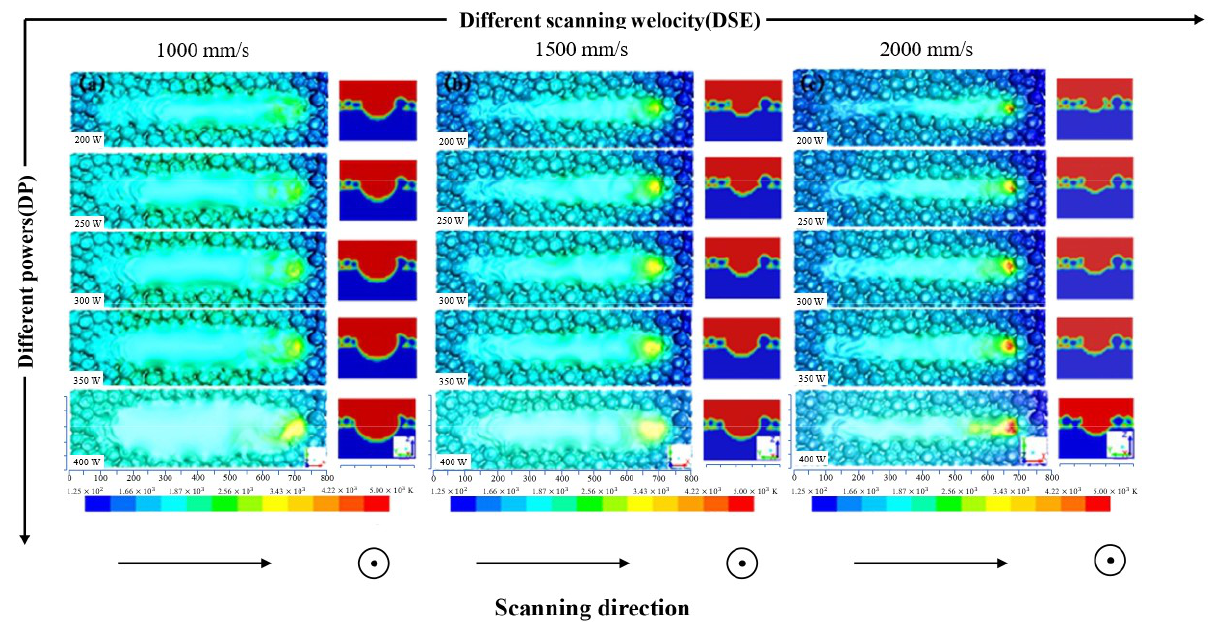
Figure 10. Influence of process parameters with laser power from 200 W to 400 W and scanning velocity from 1000 mm/s to 2000 mm/s on the melt pool geometry (in top view) and surface morphology (in section view).